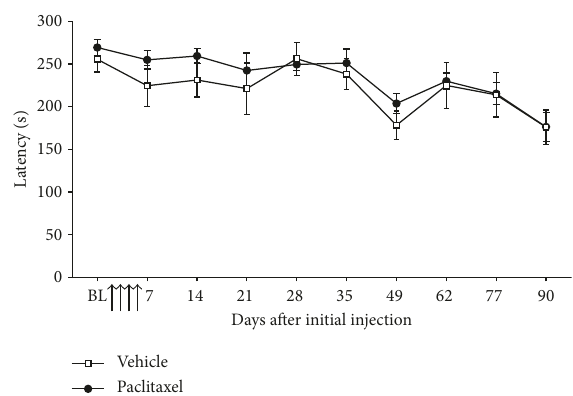
Figure 5: Effect of paclitaxel administration on motor co- ordination. Graph shows the mean SEM of the latency to fall from an accelerating RotaRod apparatus. BL baseline before paclitax- (cid:31) el/vehicle administration. Arrows indicate four injections of ± 2mg/kg paclitaxel or equivalent volume of vehicle on days 0, 2, 4, and 6 ( n 6 per group). (cid:31)